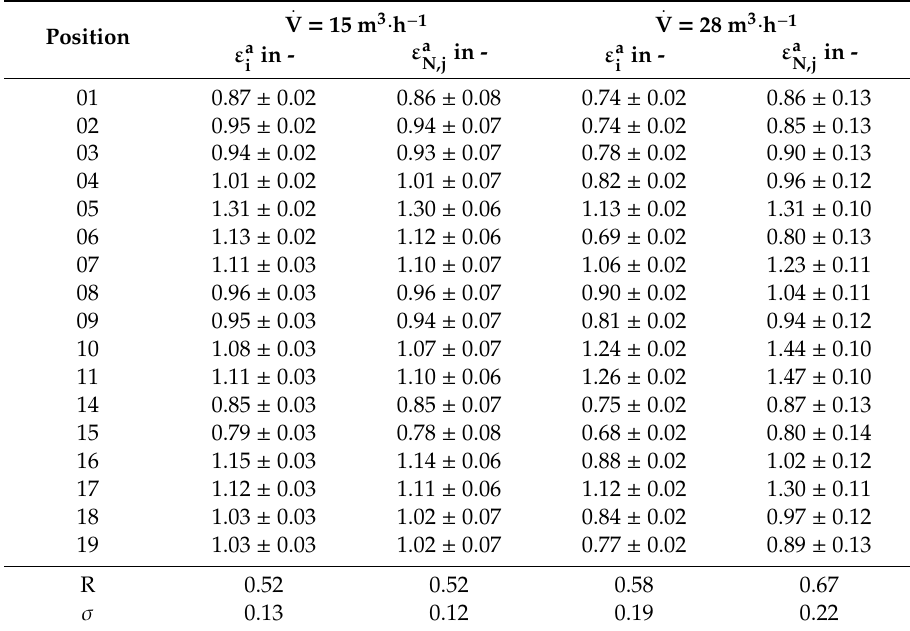
Table A2. Local air exchange at warm supply air conditions.